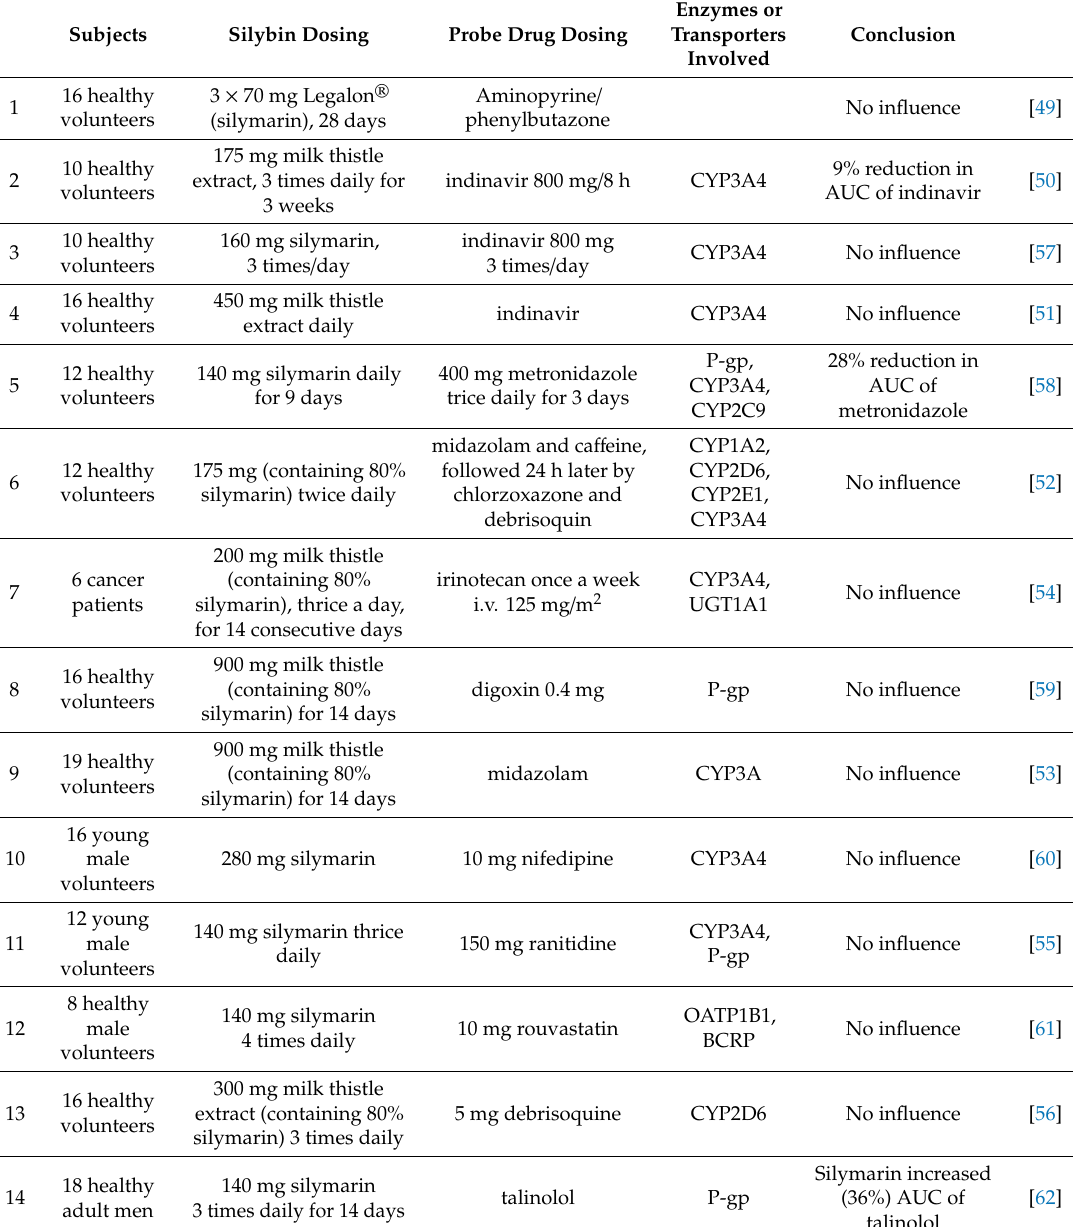
Table 1. List of published clinical trials on silybin-related drug–drug interactions